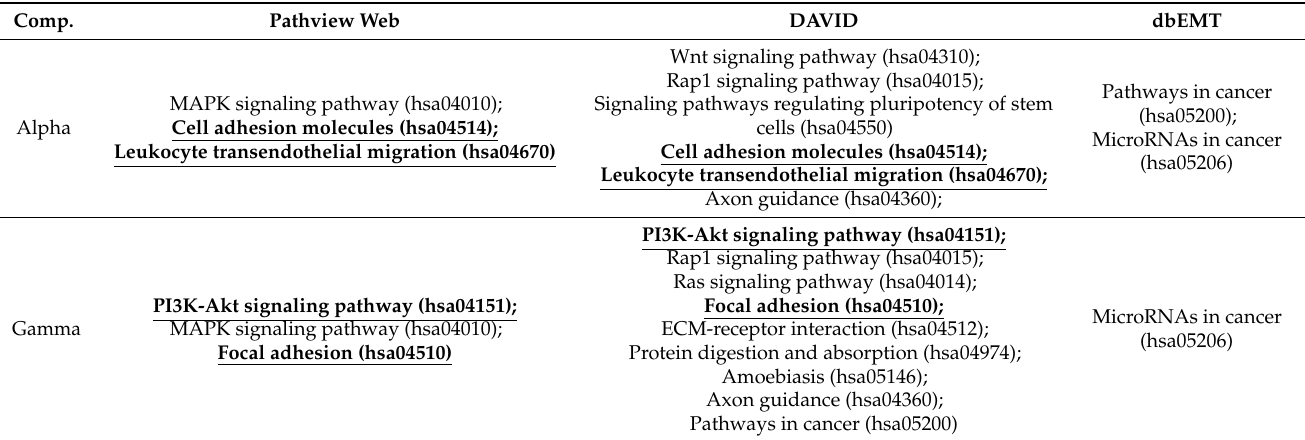
Table 2. KEGG pathways from functional annotation of AP-2 targets in ‘alpha’ and ‘gamma’ comparisons. Underlined and in bold are pathways repeated in Pathview Web and DAVID.